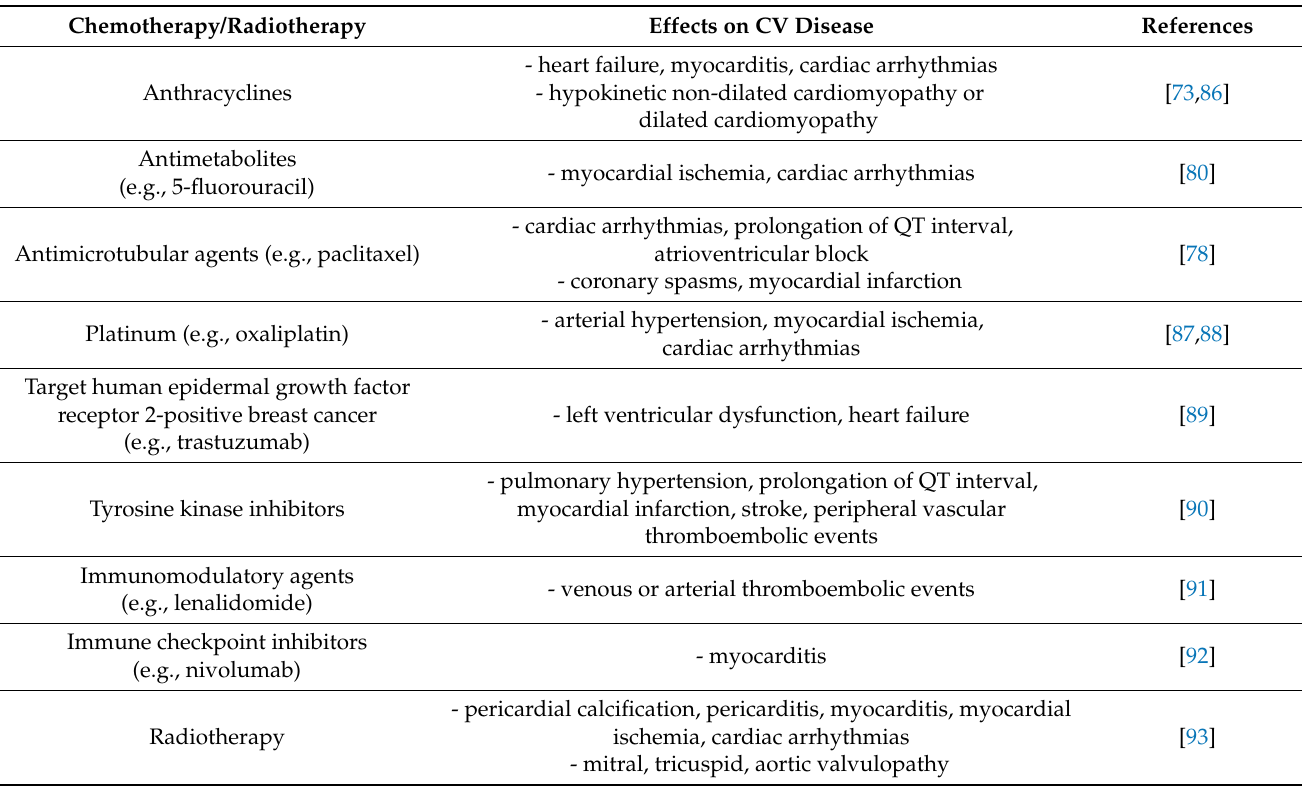
Table 2. Effects of chemo- and radiotherapy on CV